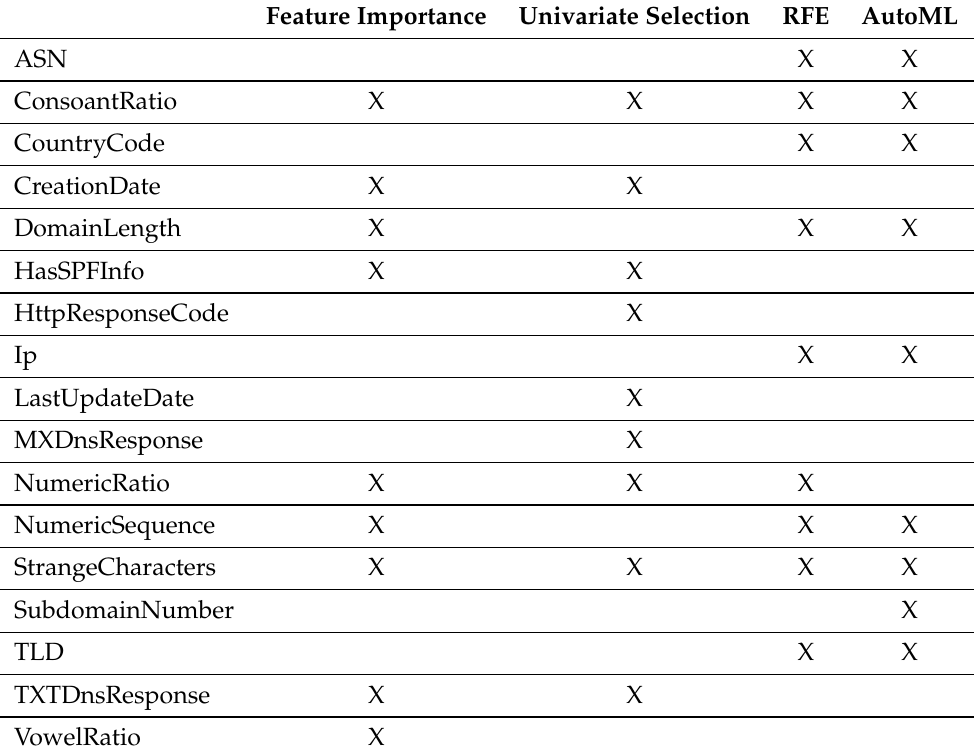
Table 5. Features importance